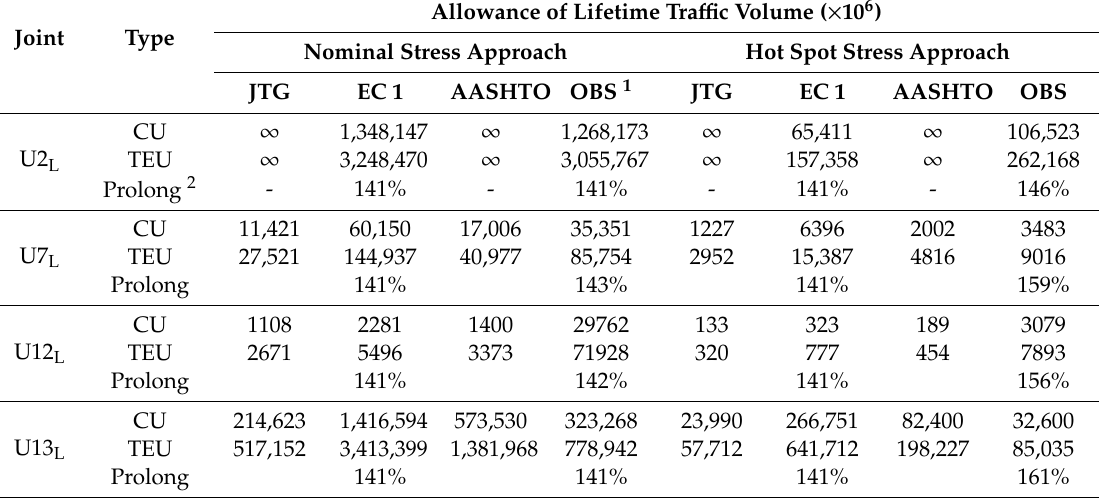
Table 4. Fatigue life of the typical rib-to-deck